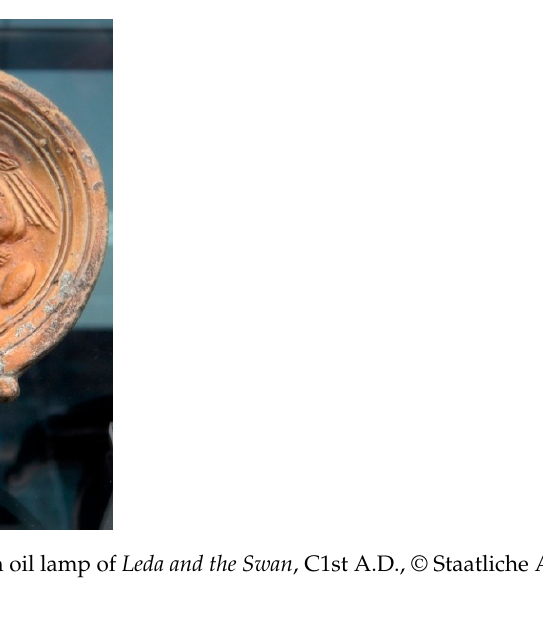
Figure 3. Roman marble relief of Leda and the Swan , C1st A.D., © The Trustees of the British Museum.